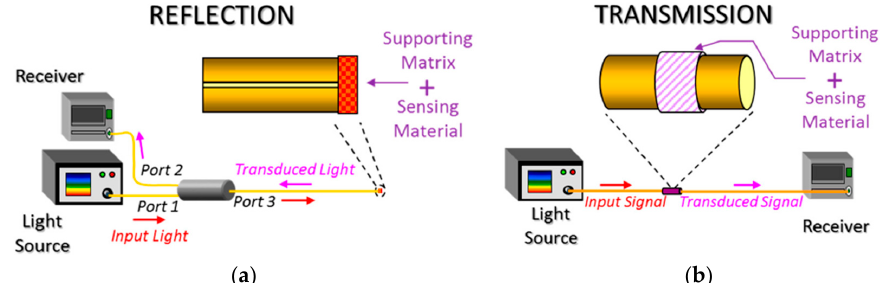
Figure 13. Schematic representation of the different architectures used for optical fiber sensors such as ( a ) reflection mode and ( b ) transmission mode. Reproduced from [130] with permission from Elosua et al. (2017).